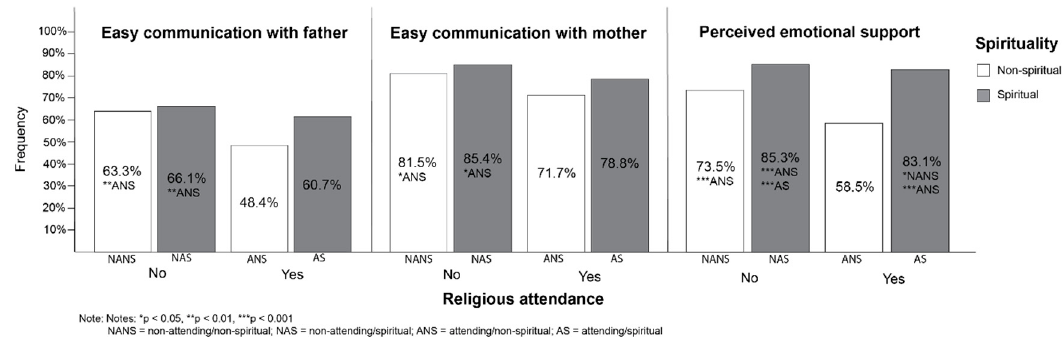
Figure 1. Prevalence of adolescent communication with parents and of perceived emotional support in groups with different combinations of religious attendance and spirituality.